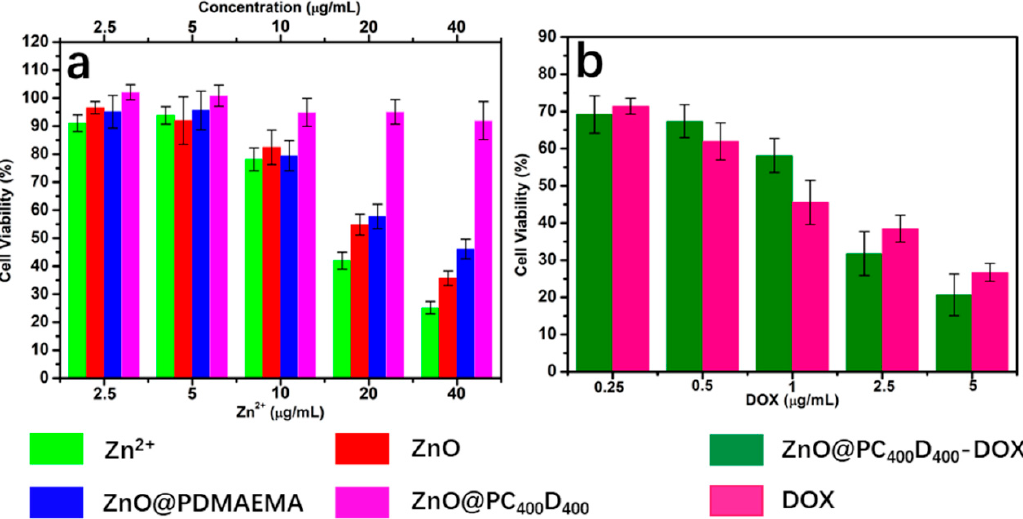
Figure 8. Cytotoxicity assay of HepG2 cells after 24 h of incubation with ( a ) ZnO QDs and comparable concentrations of Zn2+ ions, ZnO@PDMAEMA, and ZnO@PC 400 D 400 ; ( b )